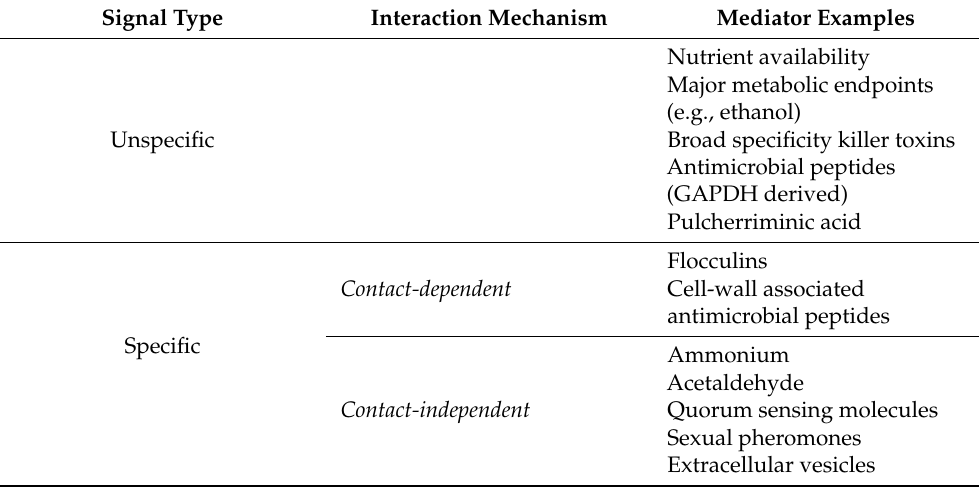
Figure 1. True yeast-to-yeast communication requires four elements. I. A transmitting yeast cell. II. The message (signal). III. A perceiving yeast cell. IV. A physiological response by the receiving cell. Table 1. Examples of communication mediators grouped by signal type.